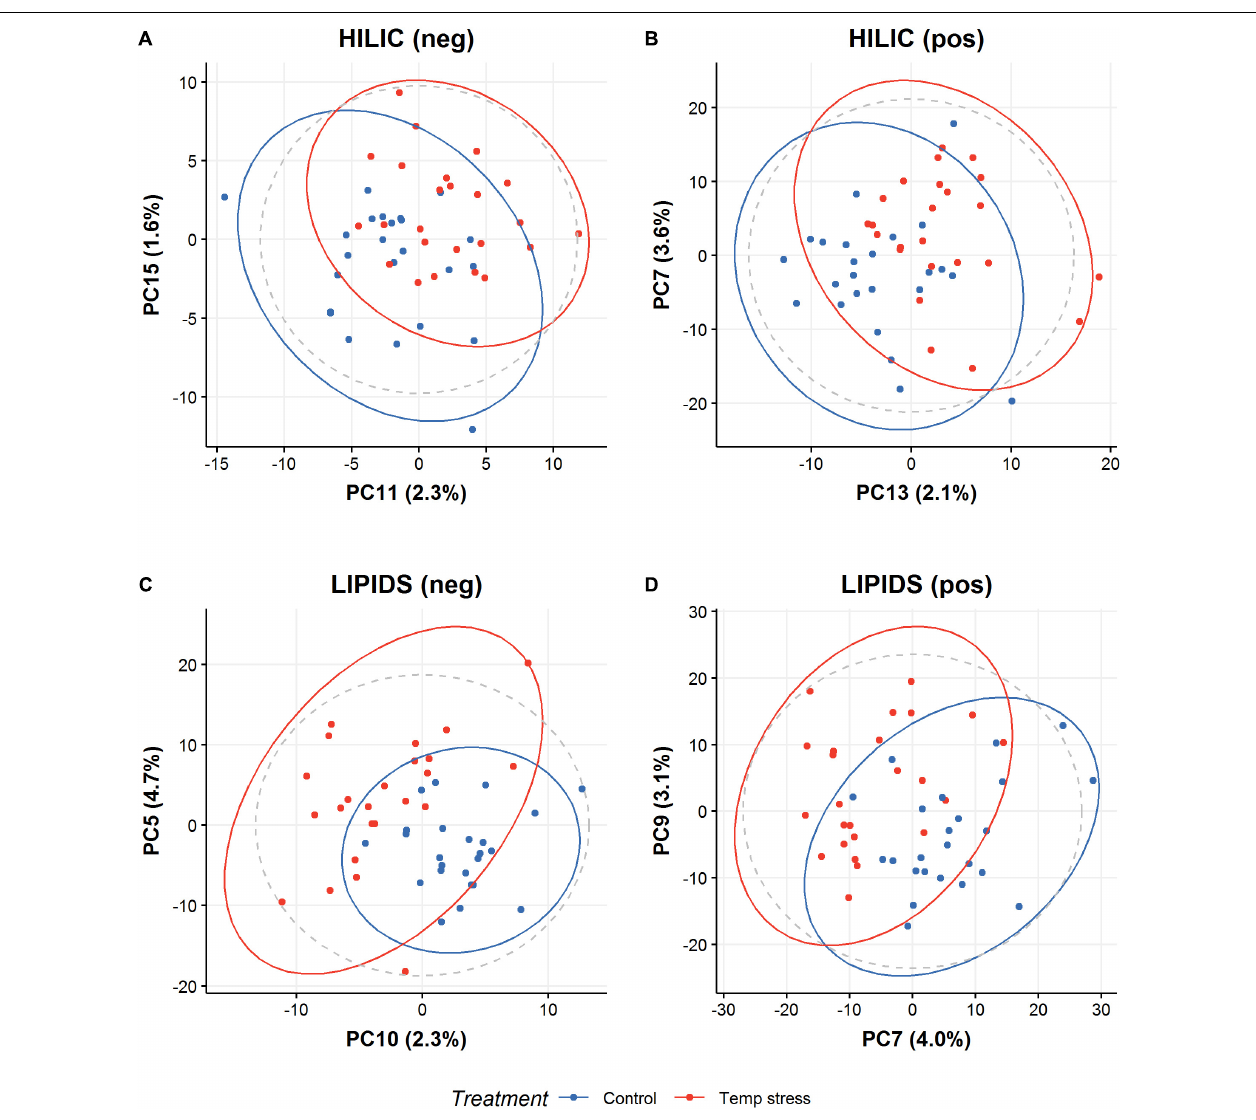
FIGURE 5 | Distribution of polar HILIC coral extracts in (A) negative mode and (B) positive mode LC-MS, and of non-polar LIPID coral extracts in (C) negative mode and (D) positive mode LC-MS. PCA representation of the effect of treatment on colonies for all methods (LIPID/HILIC and negative/positive mode LC-MS). “Late” principal components (i.e., 5, 7, 9, 10, 11, 13, and 15 instead of 1 and 2), drive the separation, suggesting any treatment effect is small compared with effects from other variables such as species